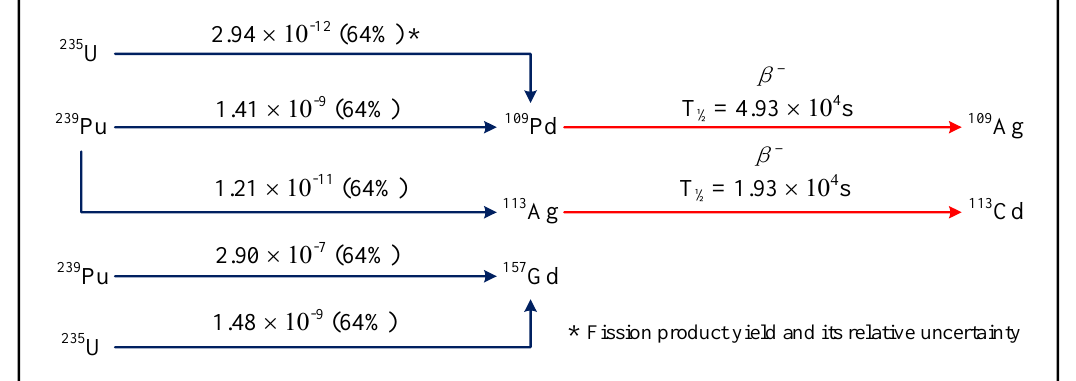
Figure 8. Special fission and decay model.